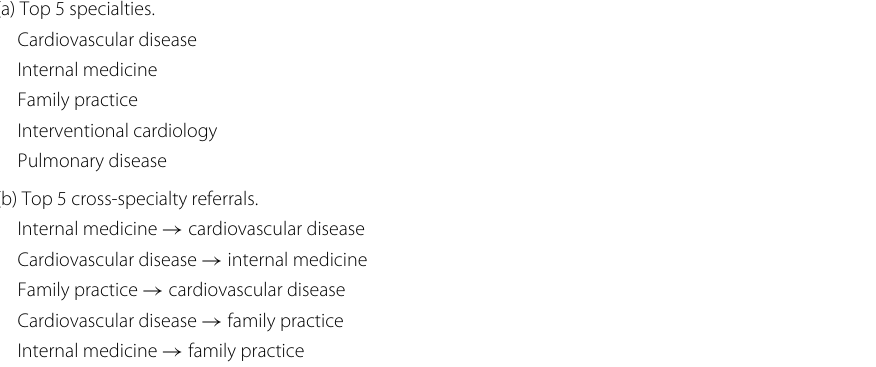
Table 5 Referrals to physician specialties over 2006-2011 (a) Top 5 specialties.